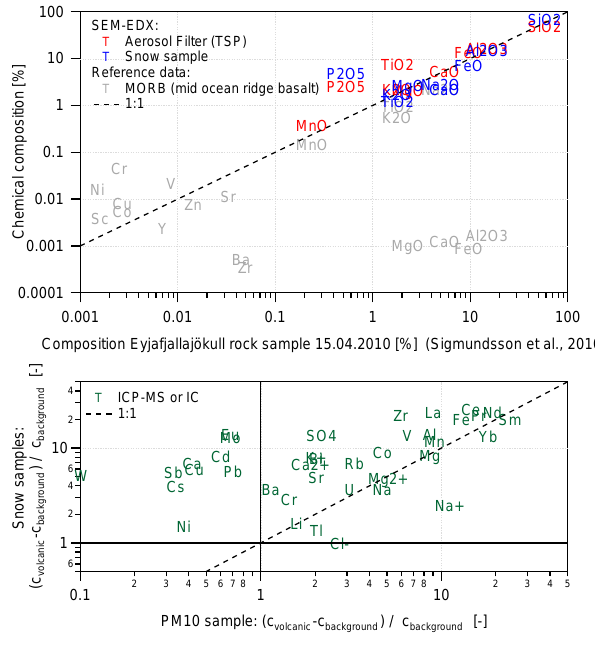
Fig. 7. Top panel: comparison of the ash particle composition (SEM-EDX) in Jungfraujoch air (18 April 2010) and snow (23 April 2010) samples with the composition of a rock sample collected at the Eyjafjallaj¨okull (15 April 2010, Sigmundsson et al., 2010). Additionally, the average composition of the mantle (MORB: Mid Ocean Ridge Basalt) is shown (Blatt et al., 2006). Bottom panel: enrichment factor of ion and trace element concentrations in air and snow samples ( c volcanic ), relative to background concentrations ( c background ) preceding the volcanic aerosol event in April. Ion and trace element concentrations were determined by IC and ICP-MS, respectively. Only elements experimentally determined both in the aerosol and snow samples are shown.